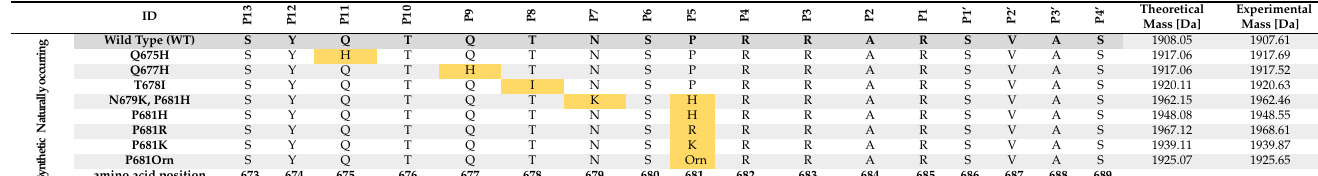
Table 1. Sequences (one-letter code for all amino acids except ornithine, which is indicated by Orn) In yellow, mutations vs. wild-type. Theoretical mass refers to the calculated monoiso- topic molecular weight; Experimental mass refers to the molecular weight found by MALDI-Mass Spectrometry